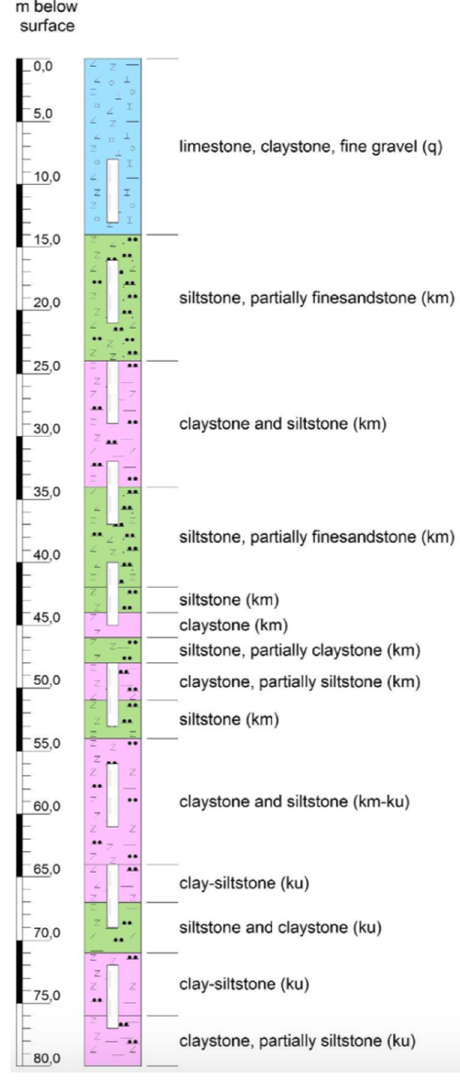
Figure A1. Well profile for well O [50].